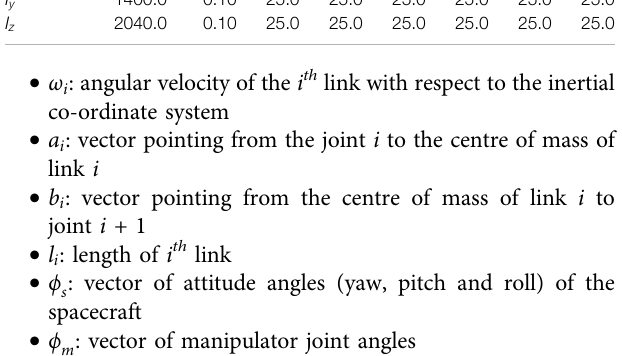
FIGURE 2 | Left: Home position of the Future Space Debris Removal Orbital Manipulator (FSDROM) (a 7-DoF redundant robot arm attached to the spacecraft); Right: Position of the Future Space Debris Removal Orbital Manipulator (FSDROM) with Manipulator capturing an orbital debris.